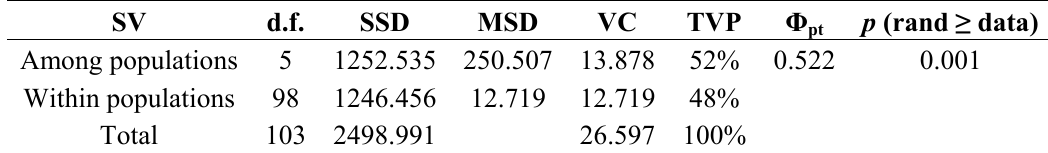
Table 2. Analysis of molecular variance (AMOVA) for the populations of C. tsoongiana . SV Among populations Within populations